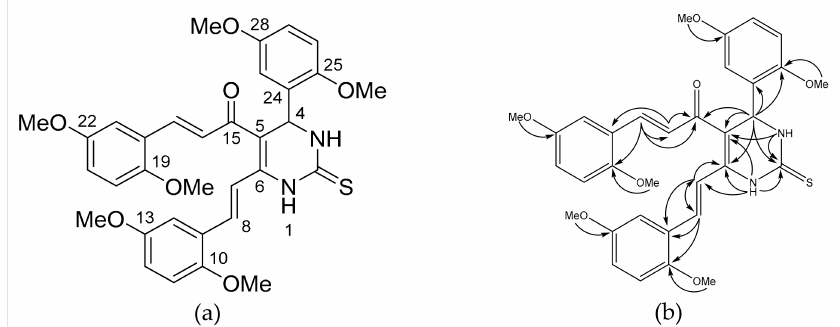
Figure 4. ( a ) Numbering of the structure, and ( b ) selected HMBC correlation for compound 6 .